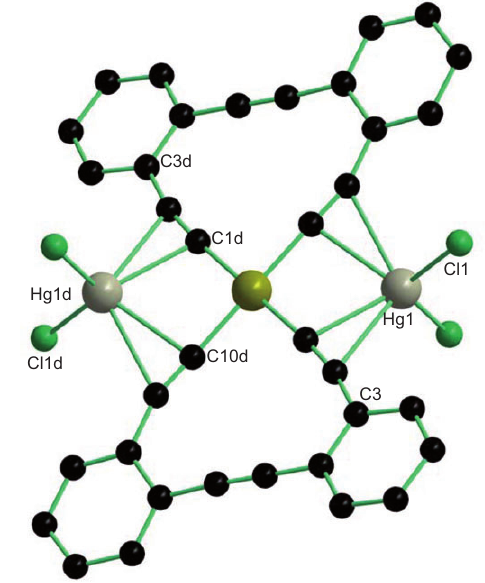
Figure 6 Structure of [Pt( μ -o-C (cid:2) CC (Zhang et al., 1997).